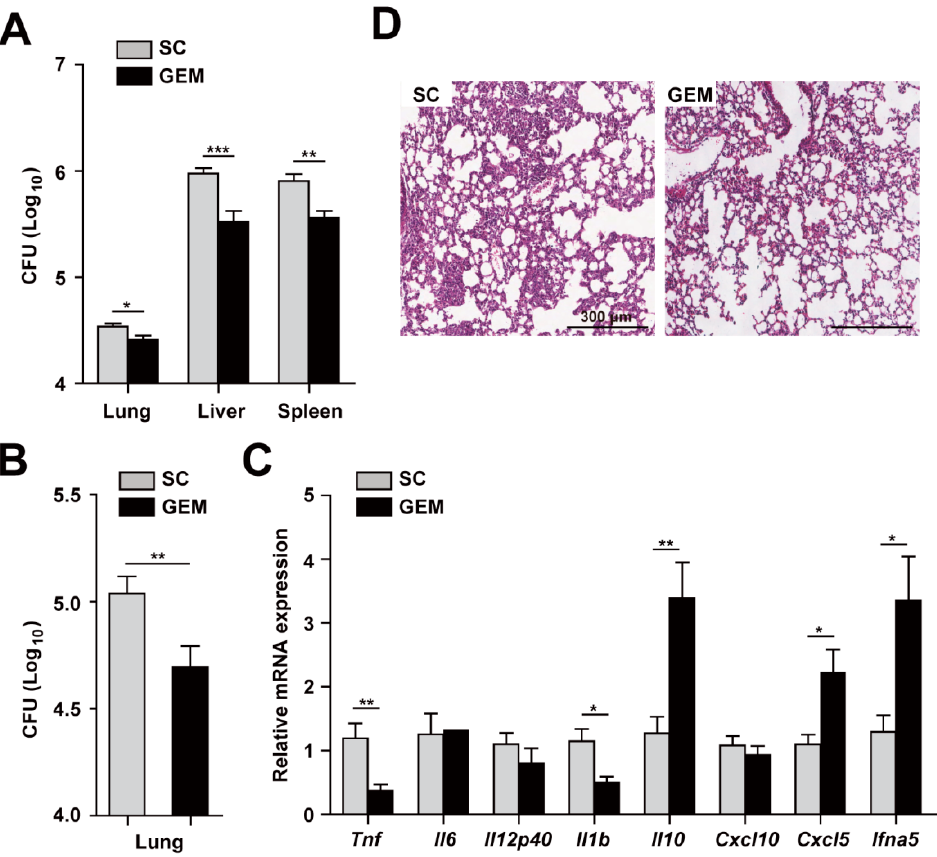
Figure 5. PPAR α activation increases host protective responses and modulates inflammation during Mabc infection. ( A ) Mice (n = 5) were infected with Mabc (iv, 1 × 10 7 CFU) and treated with solvent control (SC; 0.1% methylcellulose) or gemfibrozil (GEM; 15 mg/kg/day, dissolved in 0.1% methylcellulose). The bacterial loads in the lung, liver, and spleen were determined at 7 dpi. ( B ) Mice were infected with Mabc (in, 3 × 10 6 CFU) and treated with SC (0.1% methylcellulose) or GEM (15 mg/kg/day, in 0.1% methylcellulose), and the bacterial load in the lung was determined at 7 dpi. ( C ) Proinflammatory cytokine and chemokine mRNA levels in lung tissues determined by qRT-PCR, as in 5A. ( D ) Representative H&E-stained images of lung tissues. Scale bars, 300 µ m. Data are means ± SD of three independent experiments. Images are representative of three independent experiments (C). * p < 0.05, ** p < 0.01, and *** p < 0.001. SC, solvent control.